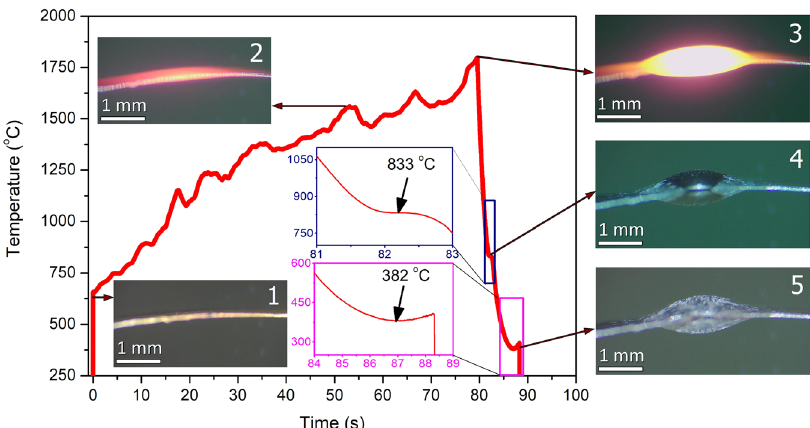
Fig. 1 Growth process of single crystal VO 2 microtube arrays. The curve depicts the change of temperature with time during the growth process. Insets no. 1 – 5 show the photographs of the V foil and the as-synthesized products at corresponding temperatures. At the beginning of heating (0 s), the temperature jumps to above 500 °C from room temperature at a very rapid and uncontrolled rate when turning on the direct current because of the very low resistance of the V foil, which results in a very large direct current being suddenly applied to the